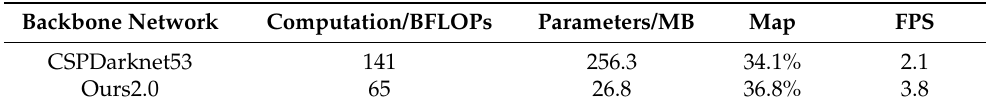
Table 1. Network improvement test